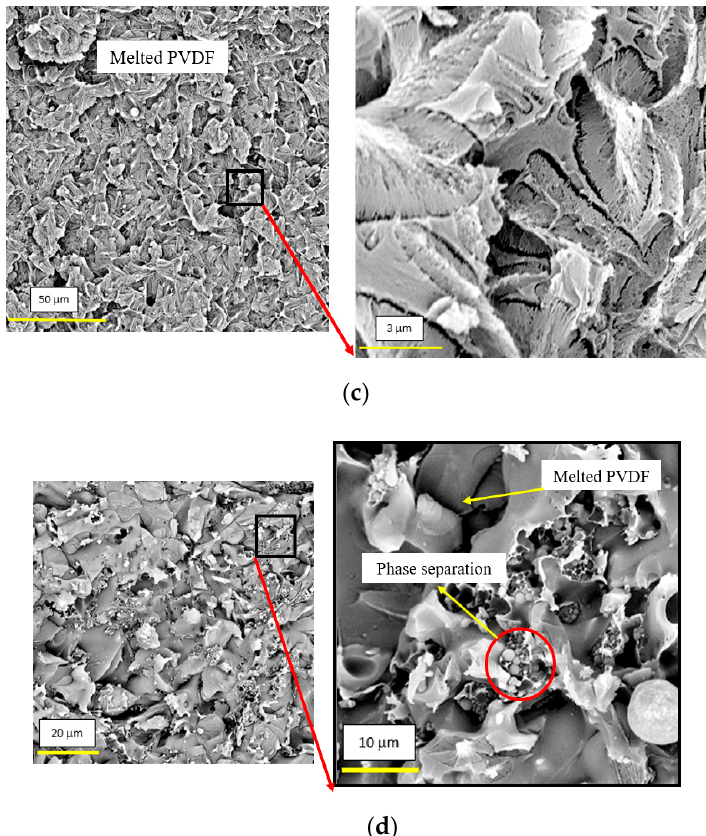
Figure 7. Morphology of fractured surface in ( a ) reference, ( b ) PSF ‐ , ( c ) PVDF ‐ , and ( d ) PVDF/PSF ‐ modified laminates.